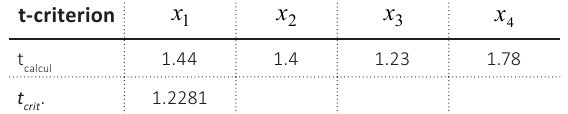
Table 5. Evaluation of the statistical significance of the regression model parameters with t-criterion t-criterion